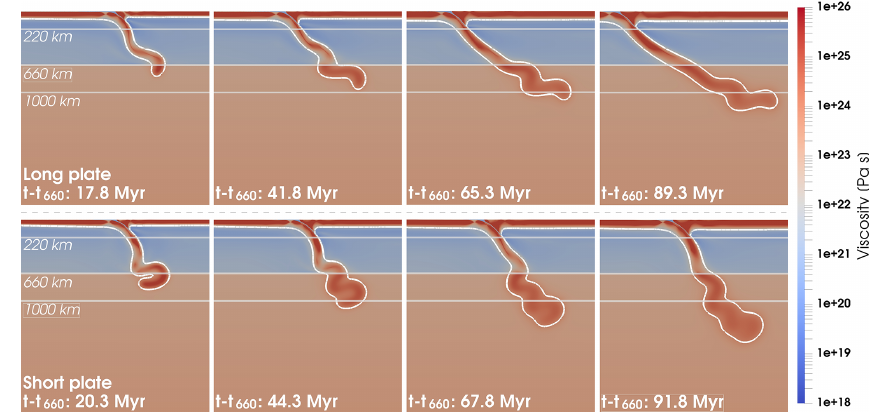
Figure 3. Viscosity field evolution at various times for the reference long-plate model (top row) and reference short-plate model (bottom row). White contour marks the 1100 ◦ C isotherm as the outline of the lithosphere. The vertical and horizontal spatial scales are identical and only part of the full model domain is shown. Note each model presents a distinct evolution of the slab and trench, which is the result of a difference in basal